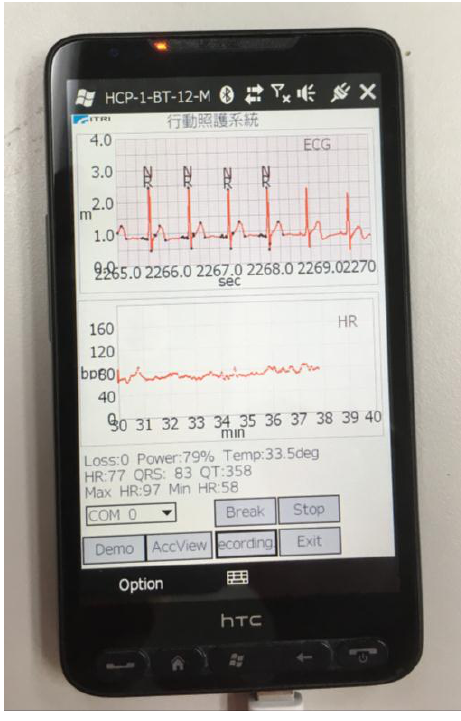
Figure 15. Implementation of daily ECG and heartrate monitoring using the proposed algorithm.